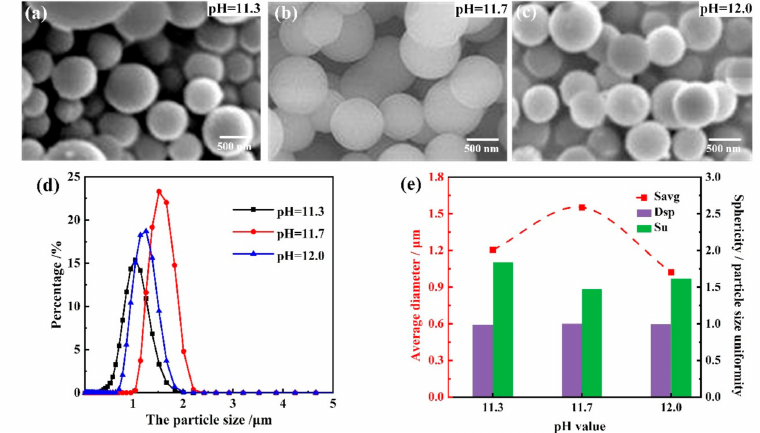
Figure 5. Morphology and particle size distribution of as-prepared PMSQ microspheres with dif- ferent base catalyst concentrations. ( a – c ) SEM images; ( d ) the particle size and distribution of the PMSQ microparticles; and ( e ) average diameter, sphericity, and particle size uniformity of PMSQ microspheres with different base catalyst